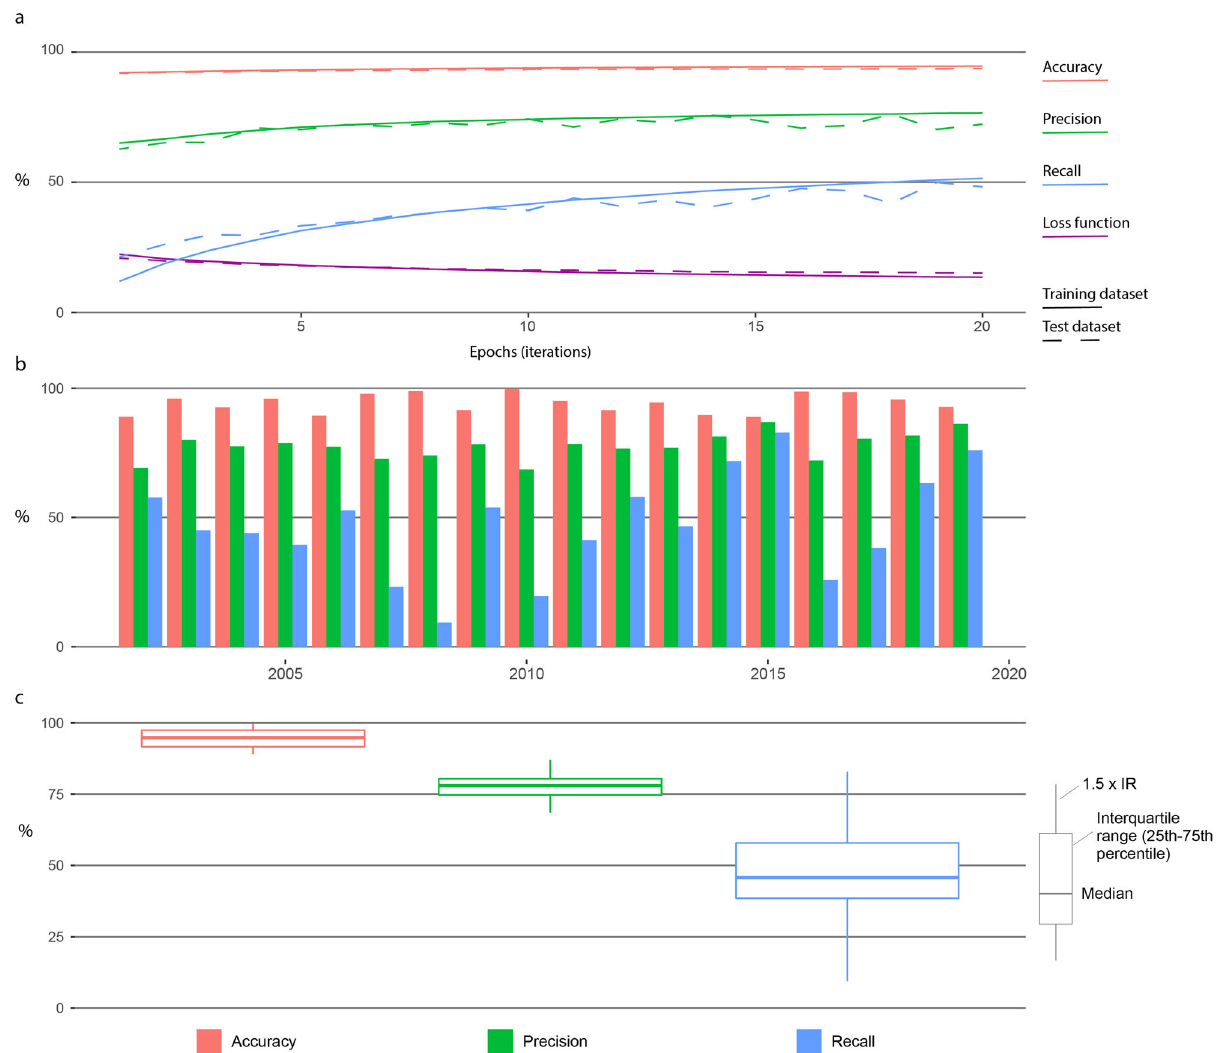
Fig. 2 FireCNN model performance. a Progression of the loss function (purple lines), recall (blue lines), precision (green lines), and accuracy (red lines) through the 20 iterations of the fi tting algorithm. b Yearly model performance metrics of accuracy (red bars), precision (green bars), and recall (blue bars) for the study period (2002 – 2019). c The same distribution of model performance metrics as shown in ( b ) here displayed as boxplots with the median (black line), interquartile range (box limits), 1.5 × interquartile range (whiskers), and outliers (points) all marked. Accuracy is the percentage of all model estimates that are correct ( fi re and not- fi re), precision is the percentage of model fi re estimates that are correct, and recall is the percentage of observed fi re hotspots that the model correctly predicted. The data used to generate ( a ) can be found in Supplementary Data 1, and the data used to generate ( b and c ) can be found in Supplementary Data